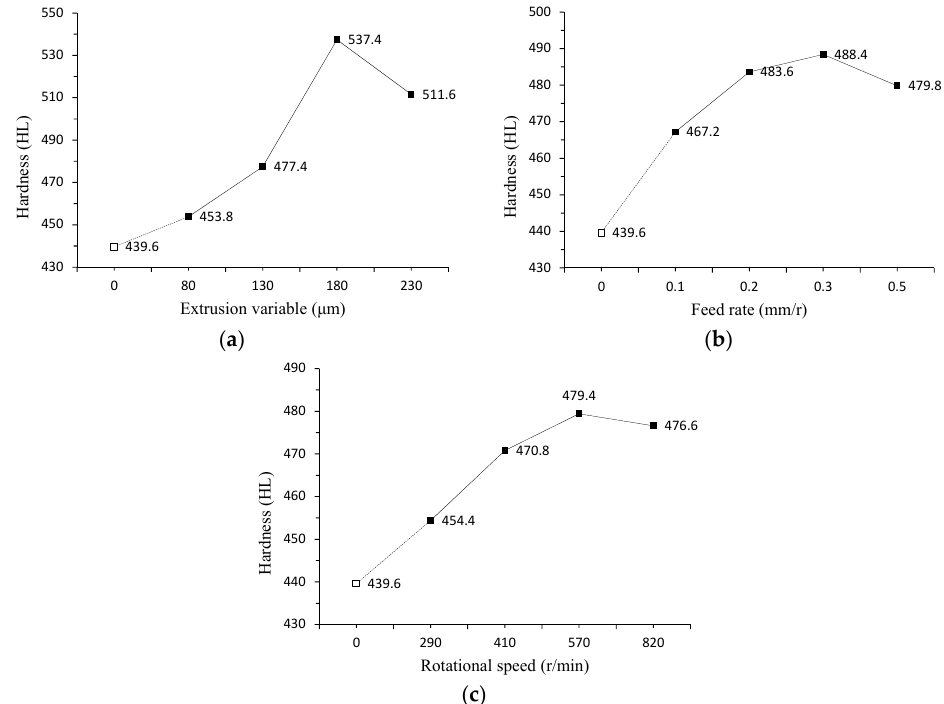
Figure 9. The variation tendency of hardness with different parameters. ( a ) Effect of the extrusion variable; ( b ) Effect of the feed rate; ( c ) Effect of the rotational speed.